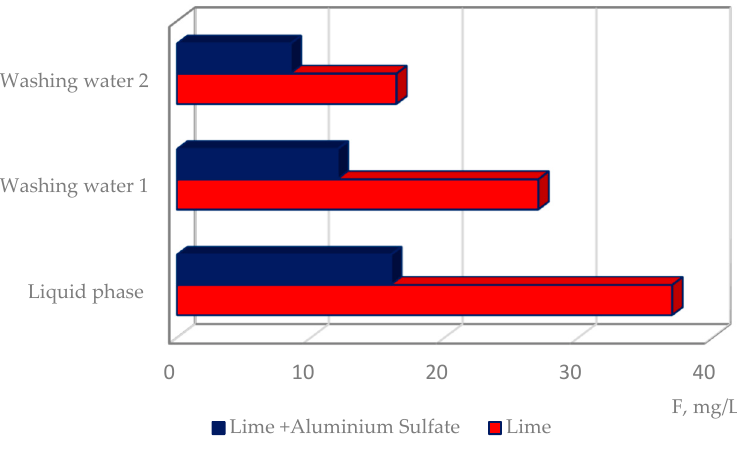
Figure 3. The effect of different reagents on the treatment efficiency of the studied sludge.